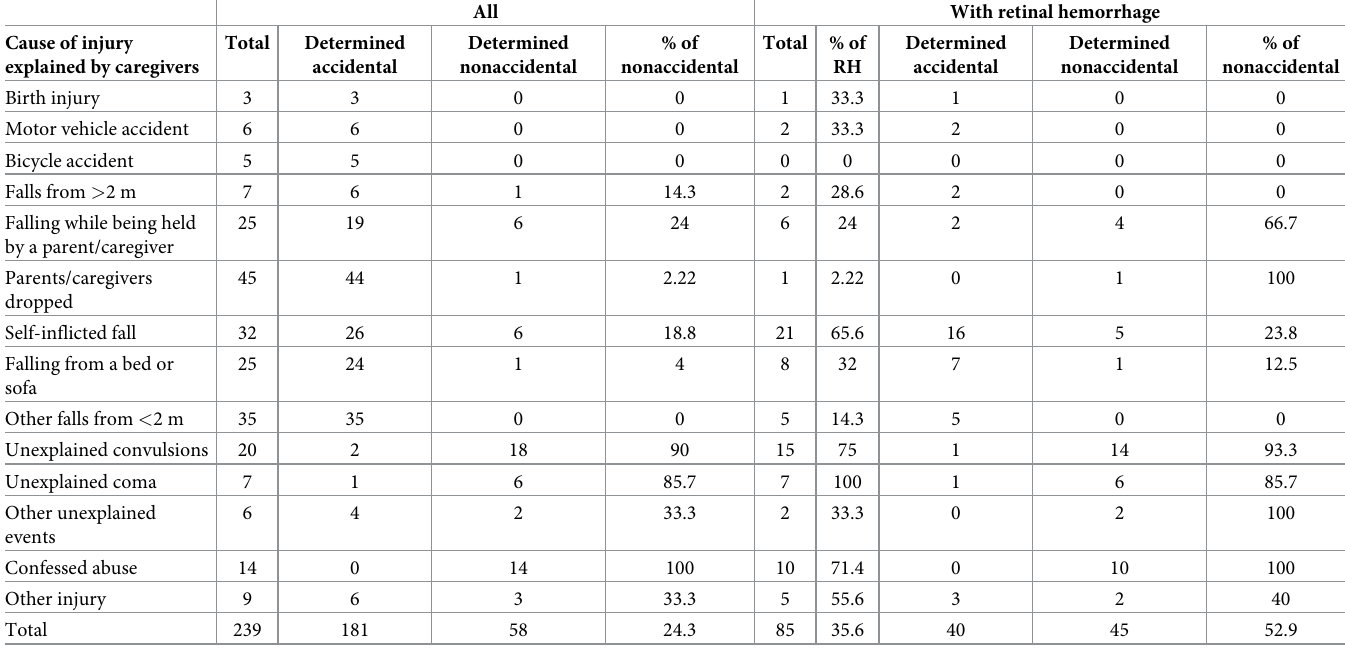
Table 3. Parents’ description of the injury mechanism and determination of nonaccidental or accidental injury in this study. All With retinal hemorrhage Cause of injury explained by caregivers